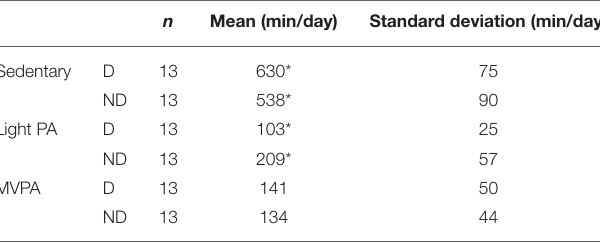
TABLE 4 | Average daily time spent in each activity intensity for the 3-day free-living data, calculated for the dominant (D) and non-dominant (ND) wrists, using the respective